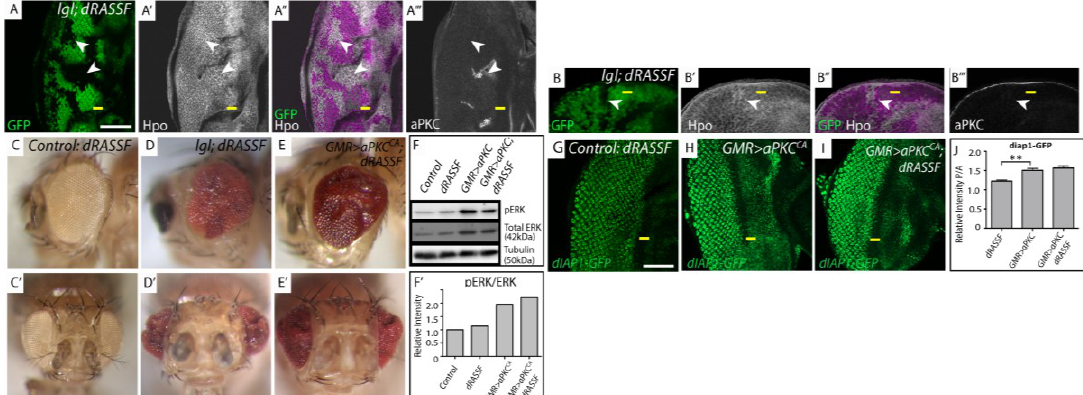
Figure 4. Hpo mislocalization in lgl −/− mosiac tissue is independent of dRASSF and dRASSF acts as a tumor suppressor. ( A , G – I ) Planar sections of larval eye discs; ( B ) Cross section of larval eye disc. Yellow line indicates morphogenetic furrow. White scale bar represents 50 µM. ( C – E ) Adult female eye images. ( A ) lgl ; dRASSF double mutant tissue (GFP negative) displays apical accumulation of Hpo (white, arrowhead indicates double mutant, GFP negative tissue) compared to dRASSF mutant tissue (GFP positive) and is mislocalized basolaterally in lgl ; dRASSF double mutant tissue ( B arrowhead). aPKC staining (white) is altered where the tissue shows obvious folds ( A , white asterik) but is still localized apically in lgl ; dRASSF double mutant tissue ( B ); ( C , C' , D , D' , E , E' ) Adult female eye images, side and ventral views respectively; ( C , C' ) dRASSF ; ( D , D' ) lgl ; dRASSF ; ( E , E' ) GMR > aPKC CA , dRASSF. The eye size of lgl mosaic and GMR > aPKC CA overexpressing adult eyes is increased when dRASSF is removed; ( F ) Western blot of protein extracts from eye discs detecting pERK, total ERK and tubulin levels; ( F' ) Graphical representation of signal intensity from Western blots. There is a two fold increase in pERK/ERK levels in GMR > aPKC CA mutant tissue. However, removal of dRASSF does not alter the relative ratio of pERK/ERK in either a wildtype or GMR > aPKC CA tissue; ( G – H ) dRASSF , GMR > aPKC CA , GMR > aPKC CA ; dRASSF crossed with diap1-GFP1.8. GFP expression (green) reports diap1 expression. Compared with the control; ( G ) dRASSF ; ( H ) GMR > aPKC CA ; and ( I ) GMR > aPKC CA ; dRASSF discs show elevated levels of diap1-GFP1.8 expression but there is no increase in diap1-GFP1.8 expression between GMR > aPKC CA and GMR > aPKC CA ; dRASSF tissue; ( J ) Graph of the ratio of intensity from posterior versus anterior regions of diap1-GFP1.8 expressing samples, taken from apical section. The upregulation of diap1-GFP1.8 in GMR > aPKC CA and GMR > aPKC CA ; dRASSF tissue is significant compared to dRASSF alone but there is no significant difference between GMR > aPKC CA and GMR > aPKC CA ; dRASSF tissues. n = 5 discs per sample. Error bars represent Standard Error of the Mean. ** indicates p < 0.001.